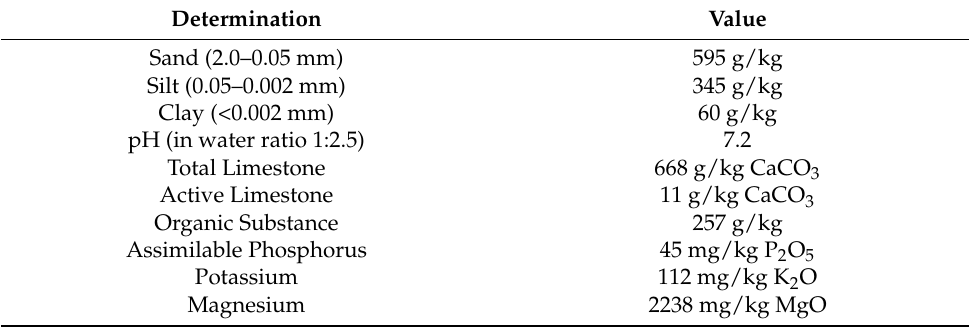
Table 1. Results of the chemical analysis of the soil used in this work.